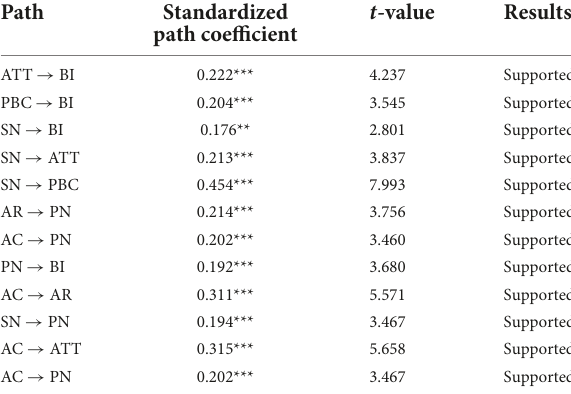
TABLE 3 Standardized path coefficients of the structural model and hypotheses